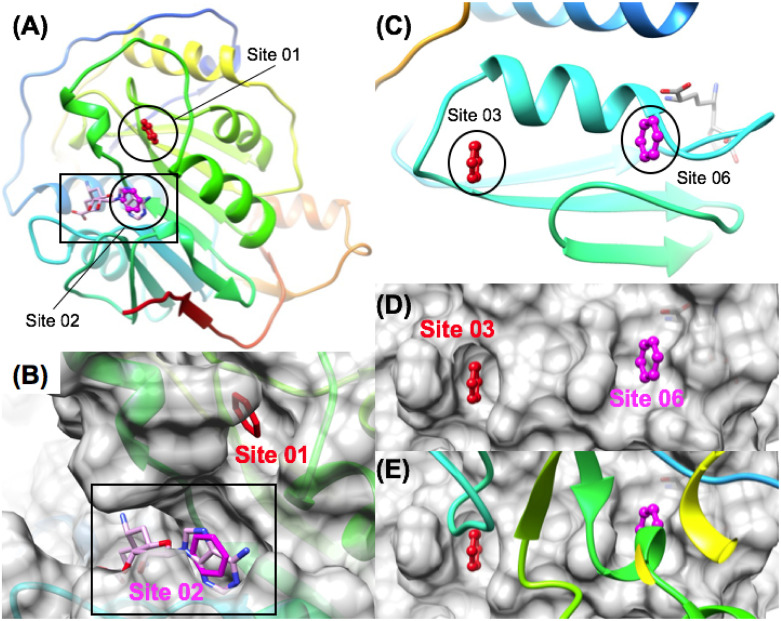
Pharmacophore mapping successfully identifies the Nsp16 sinefungin binding site and other PPI sites.The most favorable two sites identified are shown on a ribbon diagram in (A) and on a surface representation in (B) where Site 01 (red) was the most favorable site identified that was proximal to Site 02 (magenta), which superimposes with the most favorable pharmacophore site in the bound sinefungin structure. Two protein-protein interaction (PPI) sites on the Nsp16 binding surface were identified as favorable aromatic pharmacophore binding sites shown in (C) and (D). Site 03 (red) and Site 06 (magenta) represent Nsp16 / Nsp10 heterodimer interaction sites where the Nsp10 ribbon is shown (E) in rainbow binding to the complementary Nsp16 surface shown in gray.